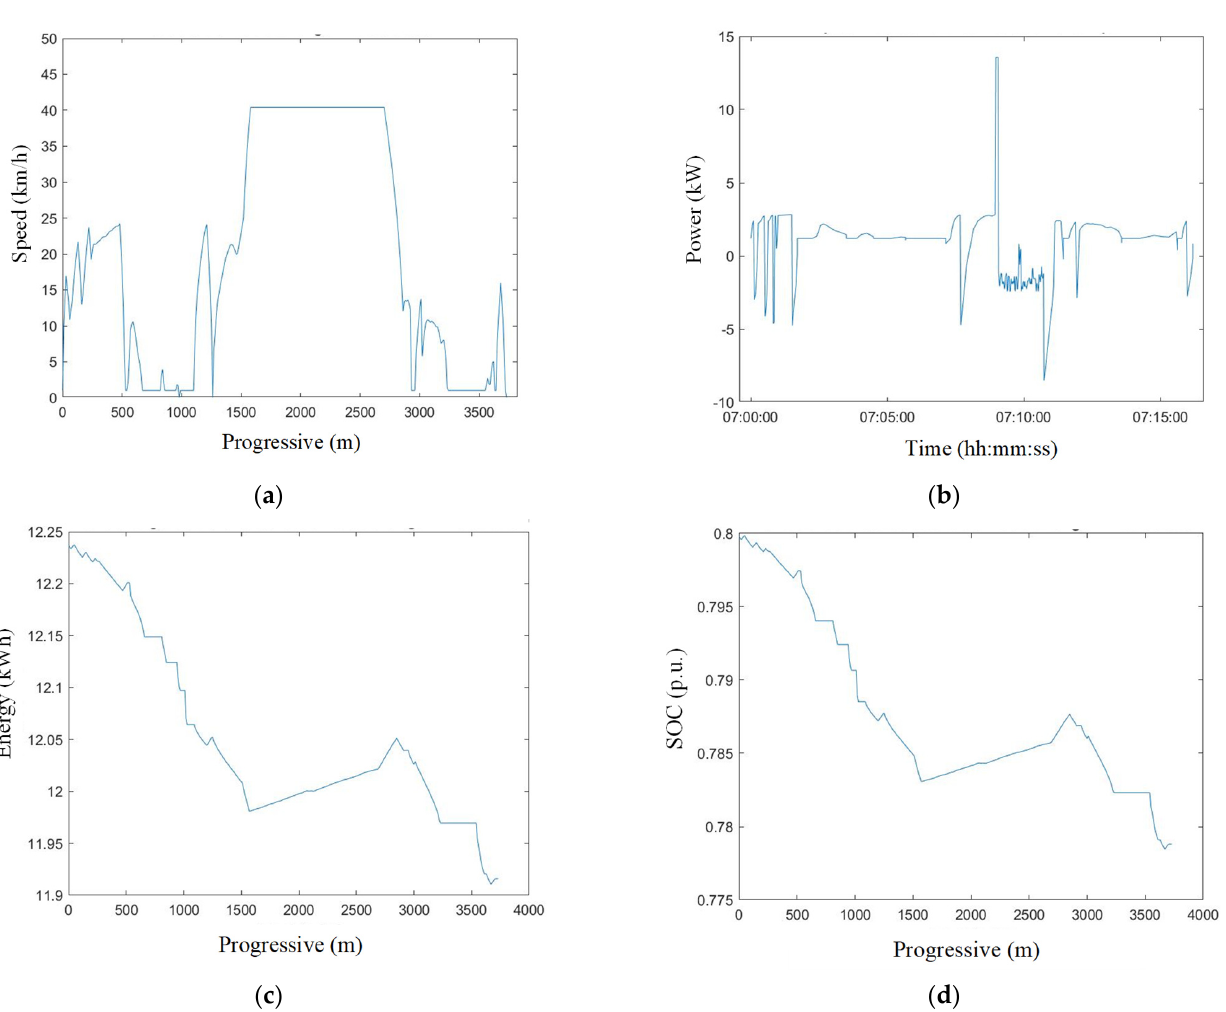
Figure 11. EV-type C performance along route 9: ( a ) Speed profile; ( b ) Power profile; ( c ) Energy profile; ( d ) SOC profile.